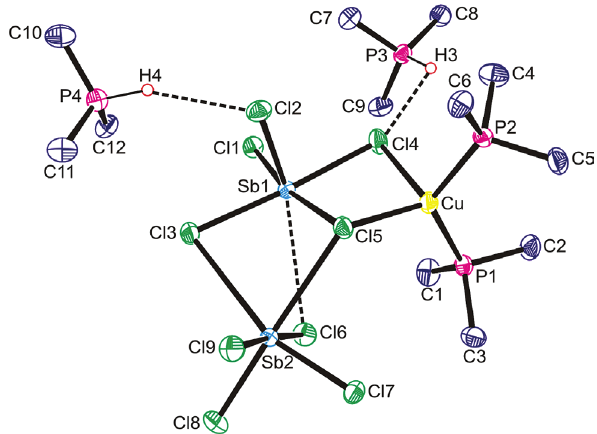
Figure 8 The asymmetric unit of 8 showing the labeling scheme used. Thermal ellipsoids are at the 40% probability level. Hydrogen atoms, except for those involved in hydrogen bonding, have been omitted for clarity. For selected geometric data, see Table 1.